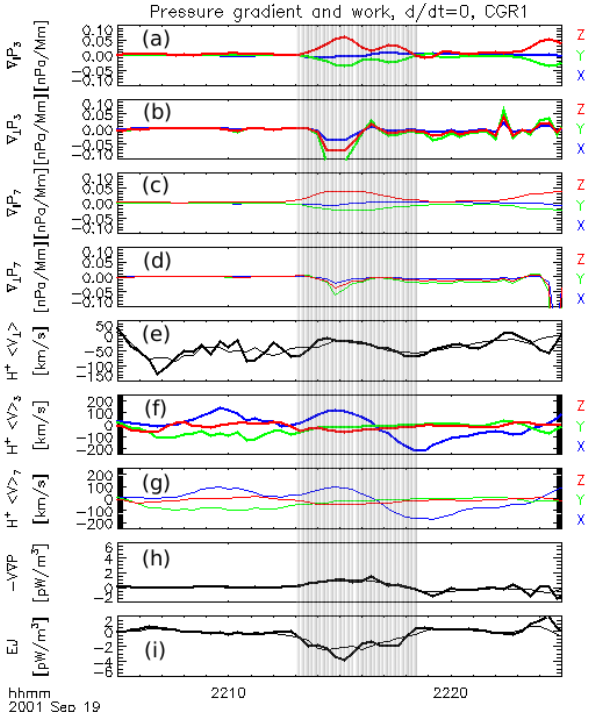
Fig. 8. Pressure gradients and the work of the pressure forces under the stationarity assumption, d p/ d t = 0. (a, b) Running average of the pressure gradient parallel to the 3-spacecraft plane, ∇ k p , and pressure gradient normal to the 3-spacecraft plane, ∇ ⊥ p , for w = 3. (c, d) Same as (a, b), but for w = 7. (e) The normal component of the H + velocity, proxy for the normal velocity U n from Eq. (36), equivalent to a quality index for the normal gradient. The thick and thin lines correspond to the estimates in the panels (b) and (d), respectively. (f, g) Running average of the H + velocity, averaged over spacecraft, for w = 3 (f) and w = 7 (g). (h, i) W K and E · J , with the same linestyles as in panel (e). W K has a flat maximum of . 2pW/m 3 , while E · J reaches a peak minimum of − 4pW/m 3 for w = 3 and a flat minimum of -2 pW/m 3 for w = 7. Unlike in the panels (d), (e), and (f) of Fig. 6, the components of the normal gra- dient are now negative (b, d), reflecting the fact that the stationarity assumption is not consistent with the geometric constraints.